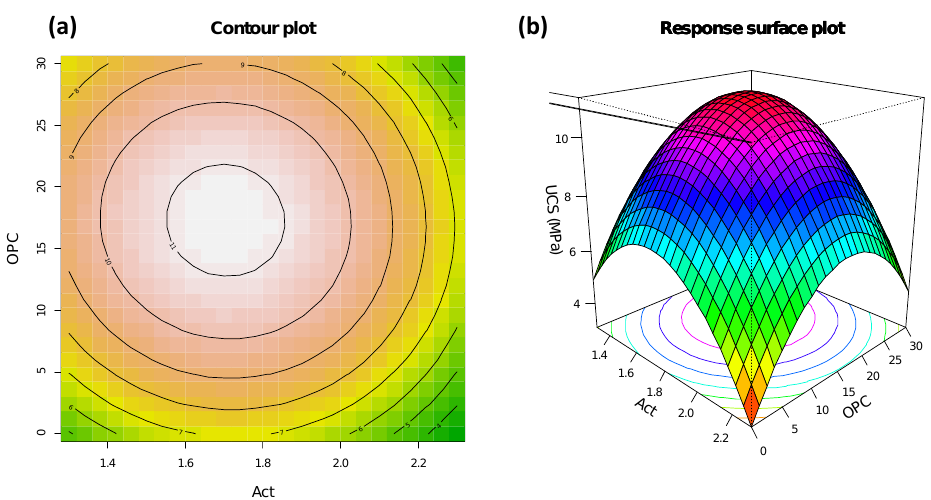
Figure 8. Results of the quadratic model: ( a ) AAHC contour map; ( b ) AAHC response surface plot.